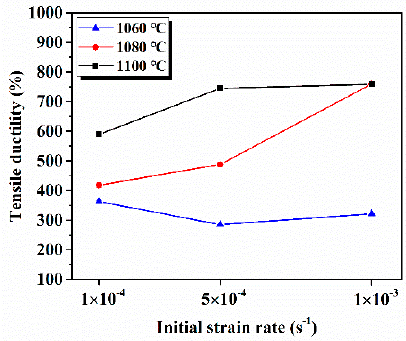
Figure 4. The stress–strain curve and tensile failure specimens at 1060 ° C ( a , b ), 1080 ° C ( c , d ) and 1100